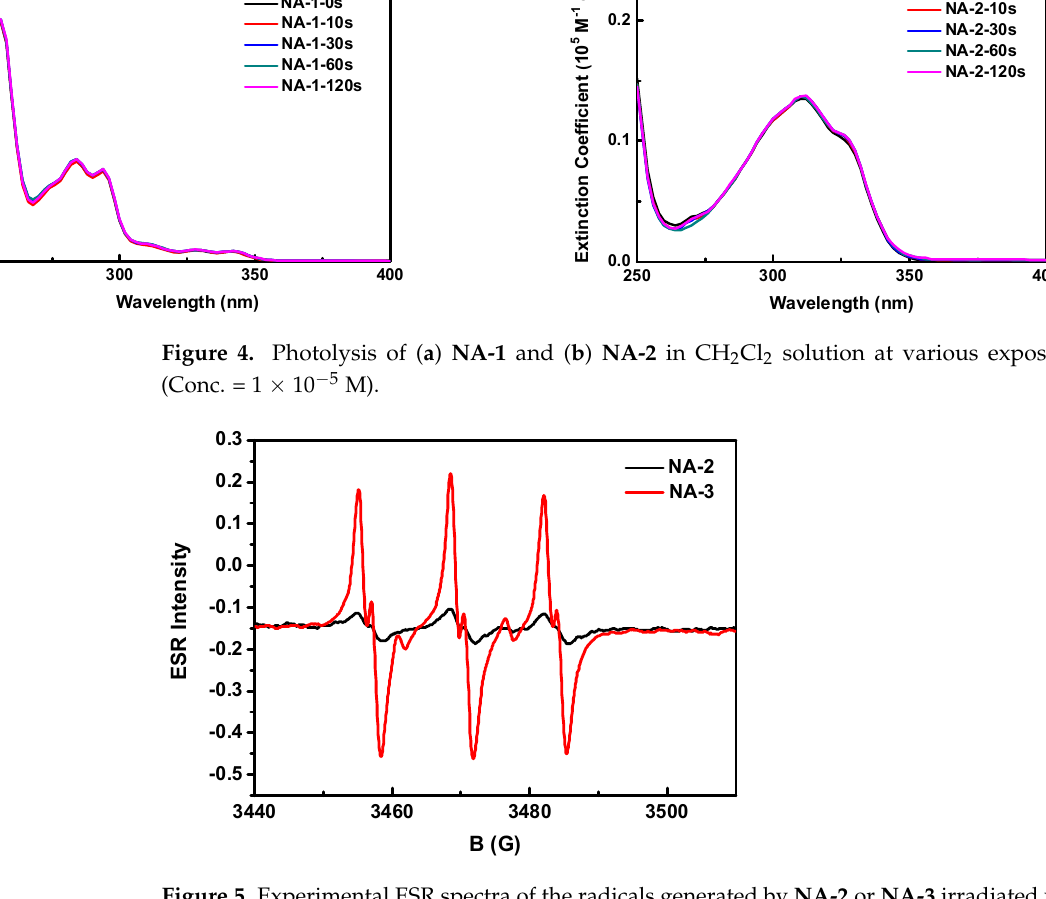
Figure 4. Photolysis of ( a ) NA-1 and ( b ) NA-2 in CH 2 Cl 2 solution at various exposure times (Conc. = 1 × 10 − 5 M).